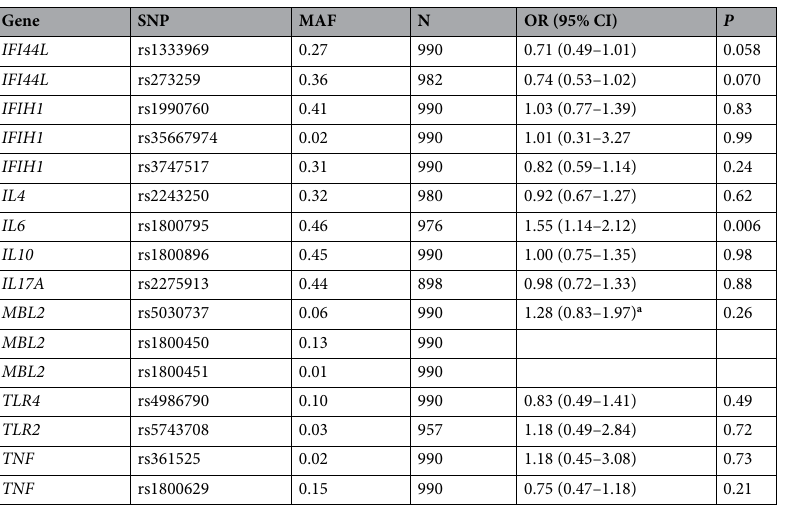
Table 2. The association between minor alleles at studied single nucleotide polymorphisms of innate immune genes and recurrent respiratory infections. N number of genotyped children, CI confidence interval, MAF minor allele frequency, OR odds ratio for recurrent respiratory infections, SNP single nucleotide polymorphism. Tested with the logistic regression analysis implemented with PLINK (Purcell) and adjusted for sex. a Calculated for minor allele at any of the three MBL2